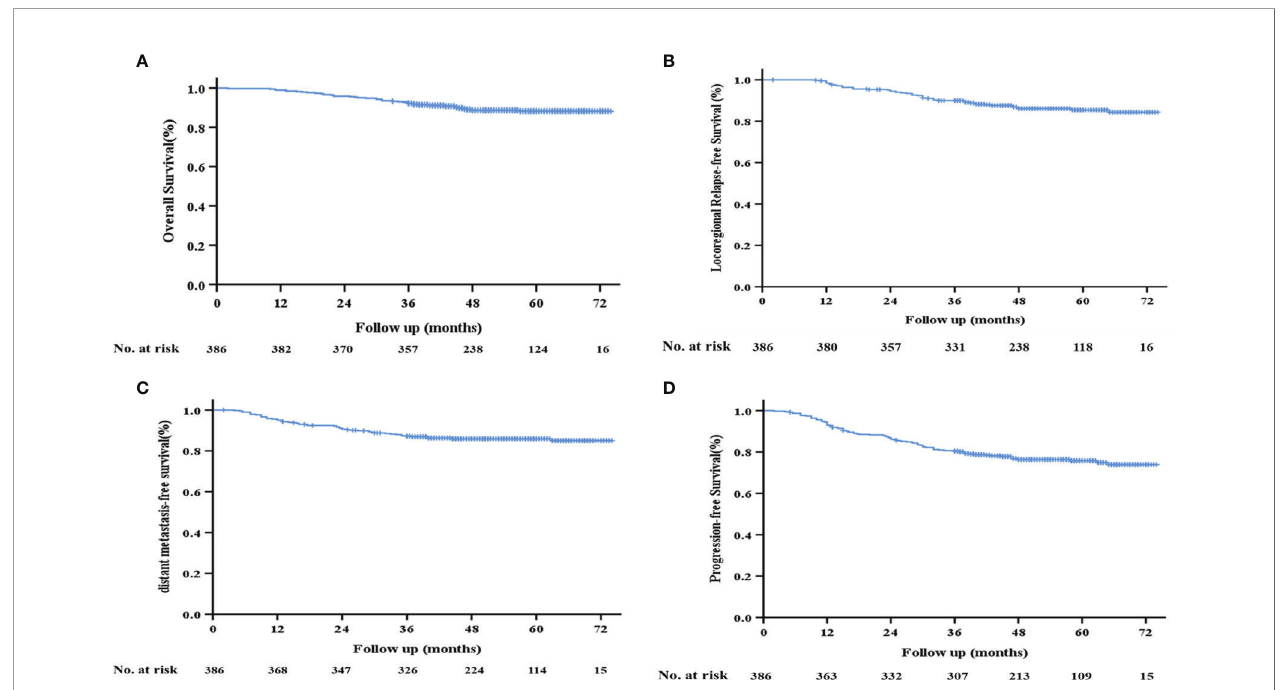
FIGURE 2 | Kaplan – Meier survival curves of the 386 patients with LA-NPC. (A) Overall survival; (B) locoregional relapse-free survival; (C) distant metastasis-free survival; (D) progression-free